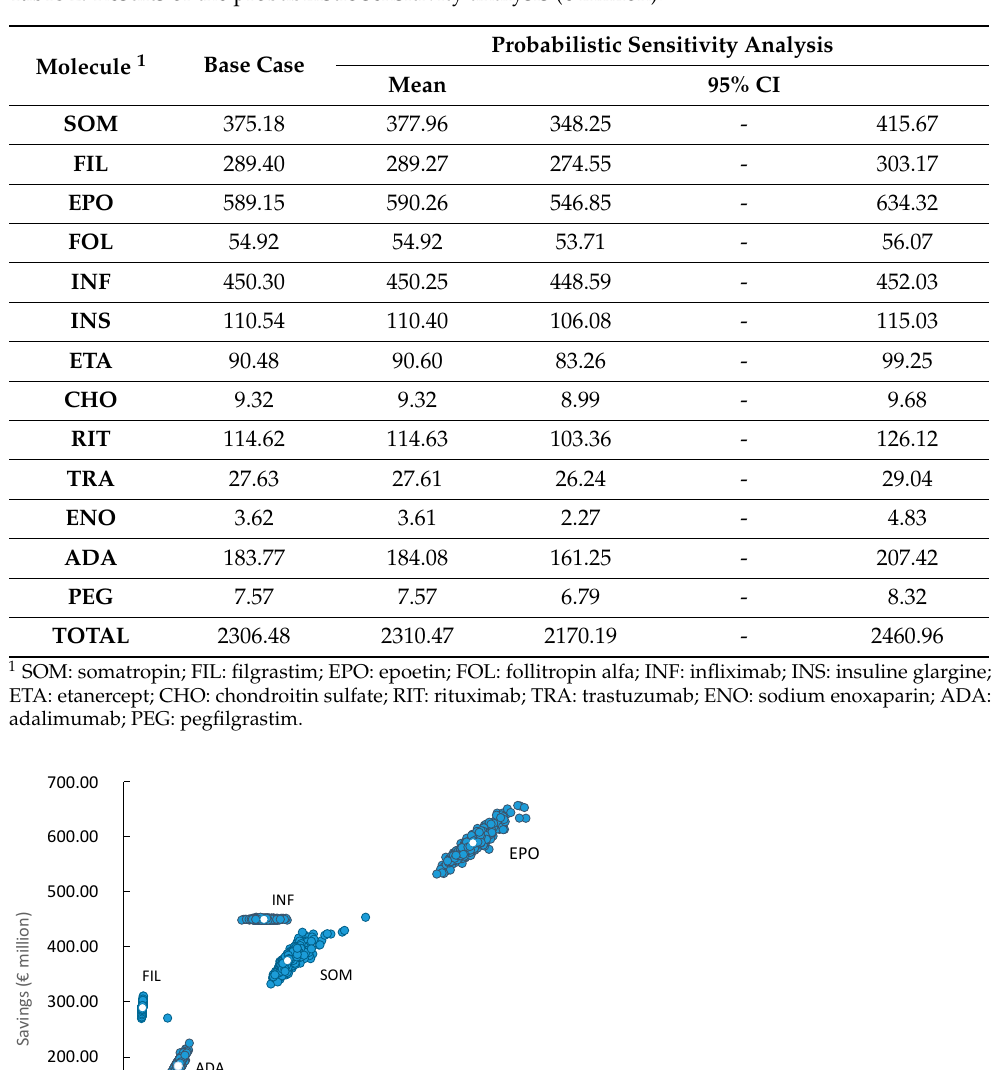
Table 2. Results of the probabilistic sensitivity analysis ( € million).